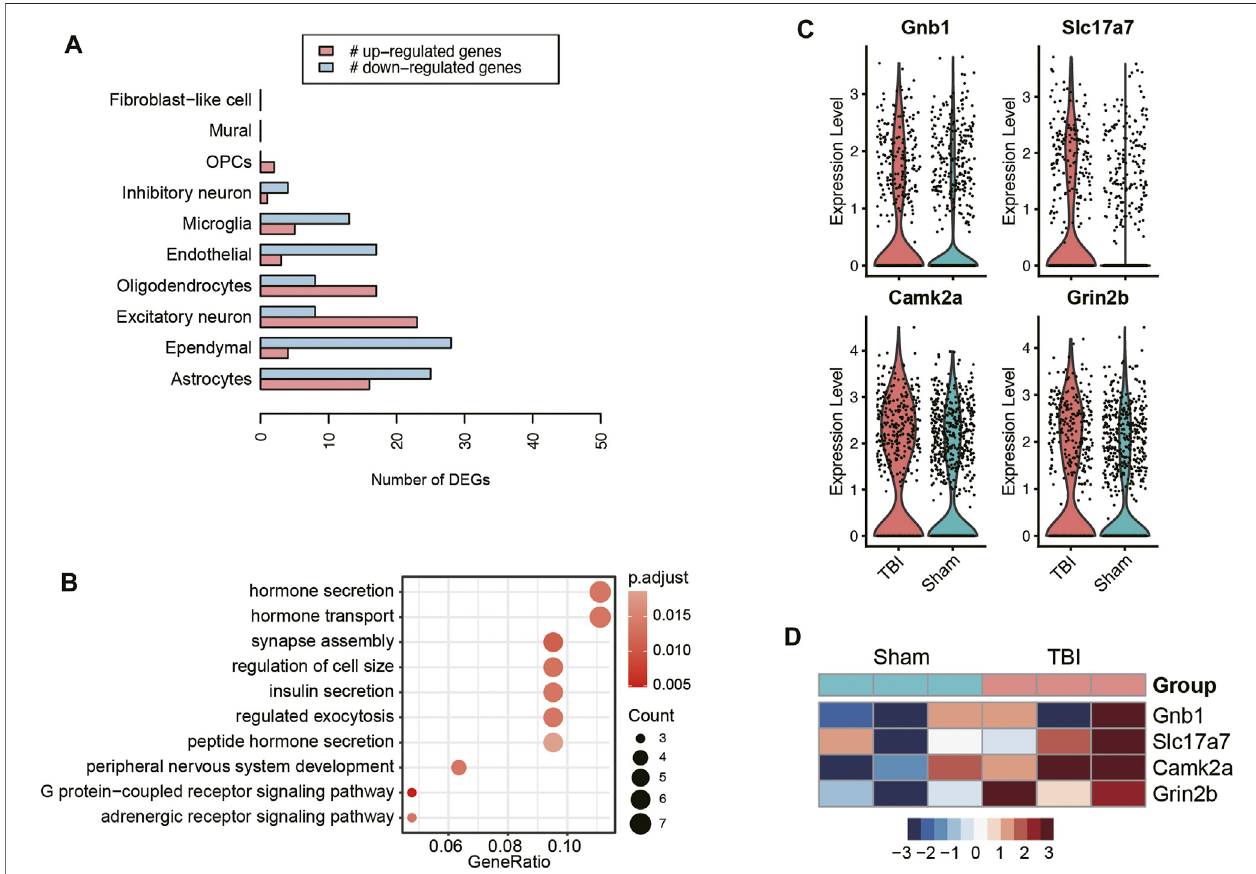
FIGURE 4 | The transcriptional changes of excitatory neurons of TBI. (A) The number of upregulated and downregulated genes in each cell type of TBI. (B) The pathwaysenrichedbytheupregulatedgenesintheexcitatoryneuronsofTBI.ThekeygenesupregulatedintheexcitatoryneuronsofTBI,visualizedatsingle-celllevel (C) and pseudo-bulk level (D)